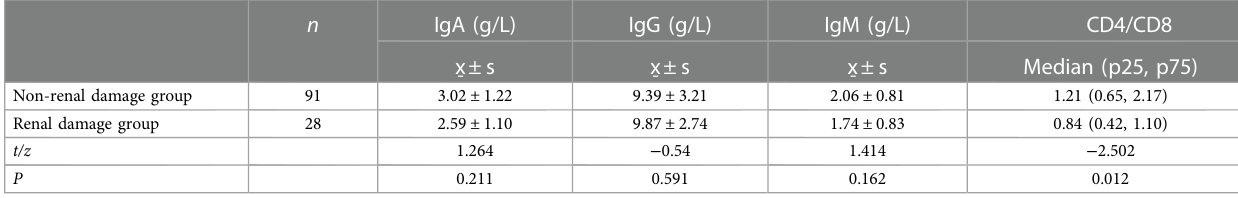
TABLE 3 Comparison of immune function between the non-renal damage group and the renal damage